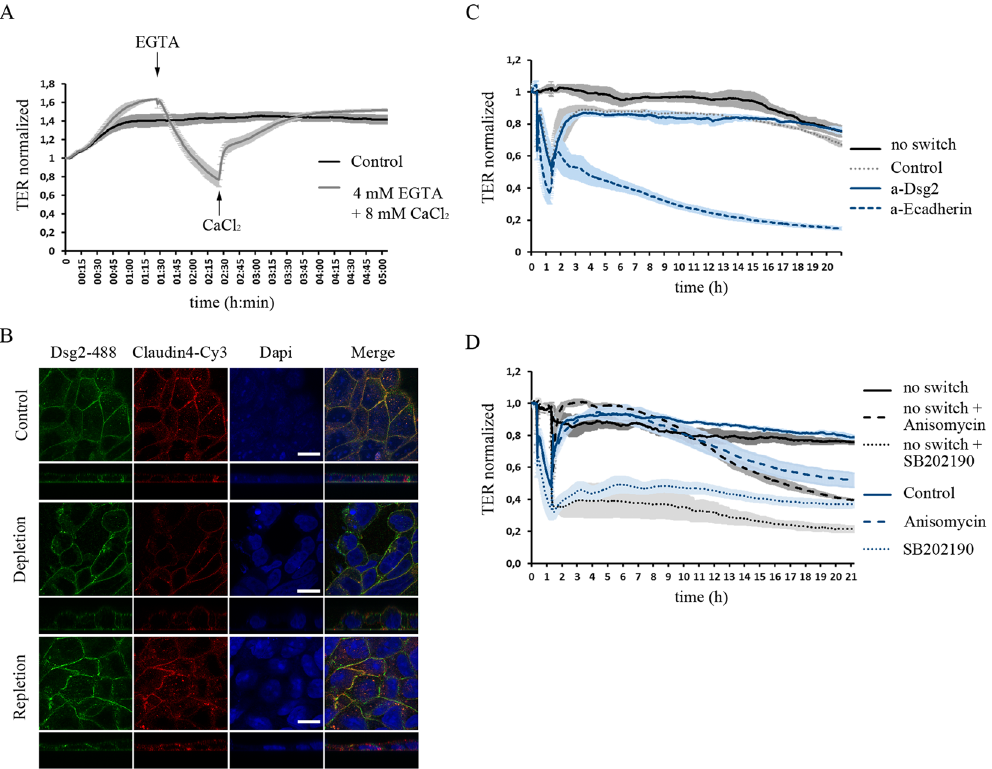
Figure 4. Well-balanced p38MAPK activity is critical for intestinal barrier function. Ca 2 + -switch assay with confluent DLD1 cells. ( A ) TER values decrease during depletion with 4 mM EGTA for 1 h and increase to back to control values during 2 h of repletion with 8 mM CaCl 2 . ( B ) Immunostaining of Dsg2 and Cld4 shows reduced and fragmented staining as well as gaps after 1 h depletion and similar staining to control condition after 2 h repletion. ( C ) Barrier reformation is not disturbed after application of a Dsg2-specific antibody but is impaired after addition of an inhibitory anti E-cadherin antibody. ( D ) TER values decrease after inhibition of p38MAPK with SB202190 and also barrier reformation is impaired in the Ca 2 + -switch experiment. Activation of p38MAPK via anisomycin has no effect in the short run but also induces reduction of TER values after about 10 h. (shown are representative graphs for at least three independent